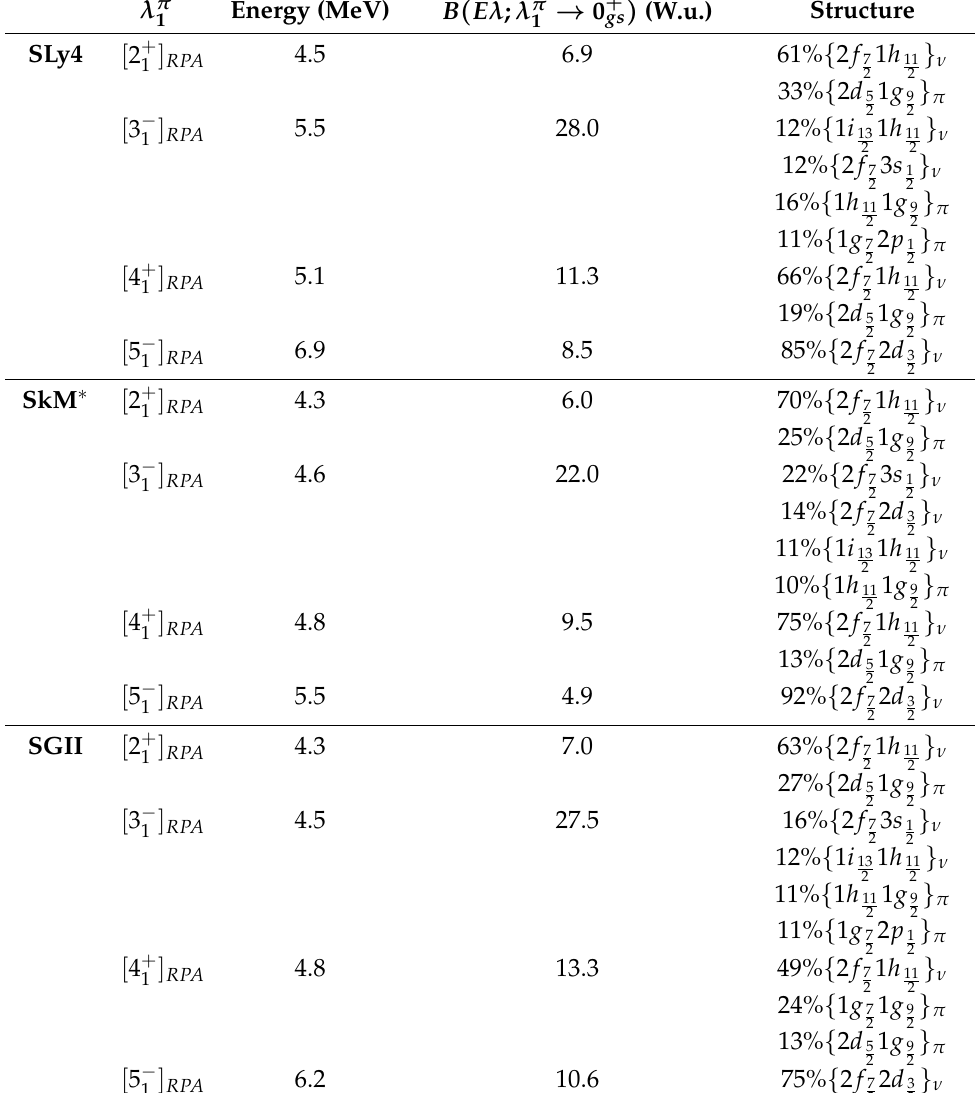
Table 1. Energies, transition probabilities, and structures of the RPA low-lying states: 2 + 5 − of 132 Sn using the Skyrme forces SLy4, SGII, and SkM ∗ . The B ( E λ ; λ π 1 Weisskopf units. The two-quasiparticle configuration contributions greater than 10% are given.